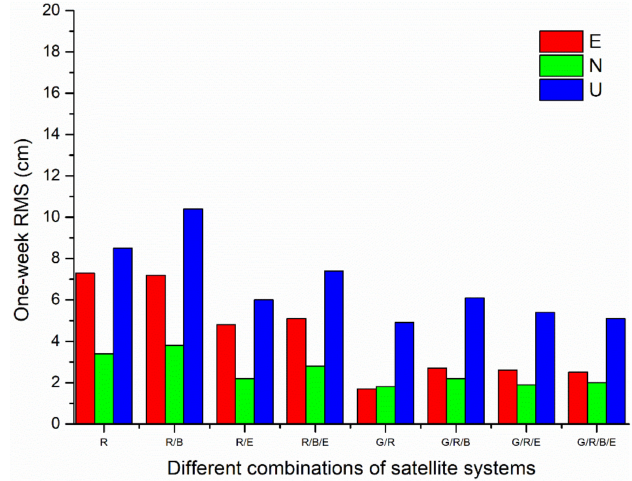
Figure 7. Positioning accuracy of different combined solutions for the NF model in kinematic mode.